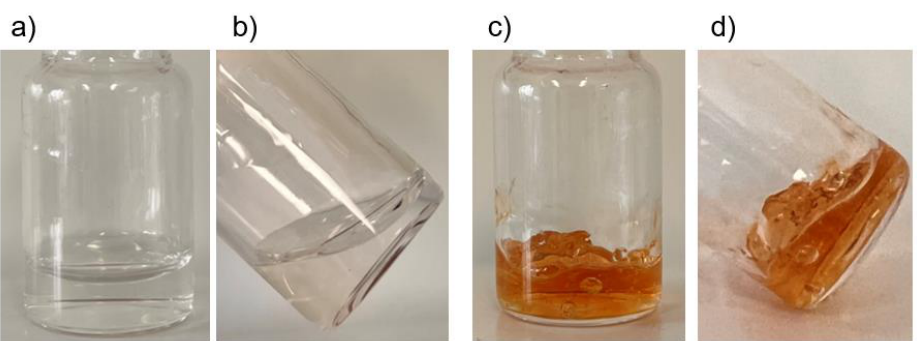
Figure 2. Macroscopic images of ( a , b ) HA-Dop, DS 5% before adding NaIO 4 . ( c , d ) HA-Dop, DS 5% 1 min after adding NaIO 4.